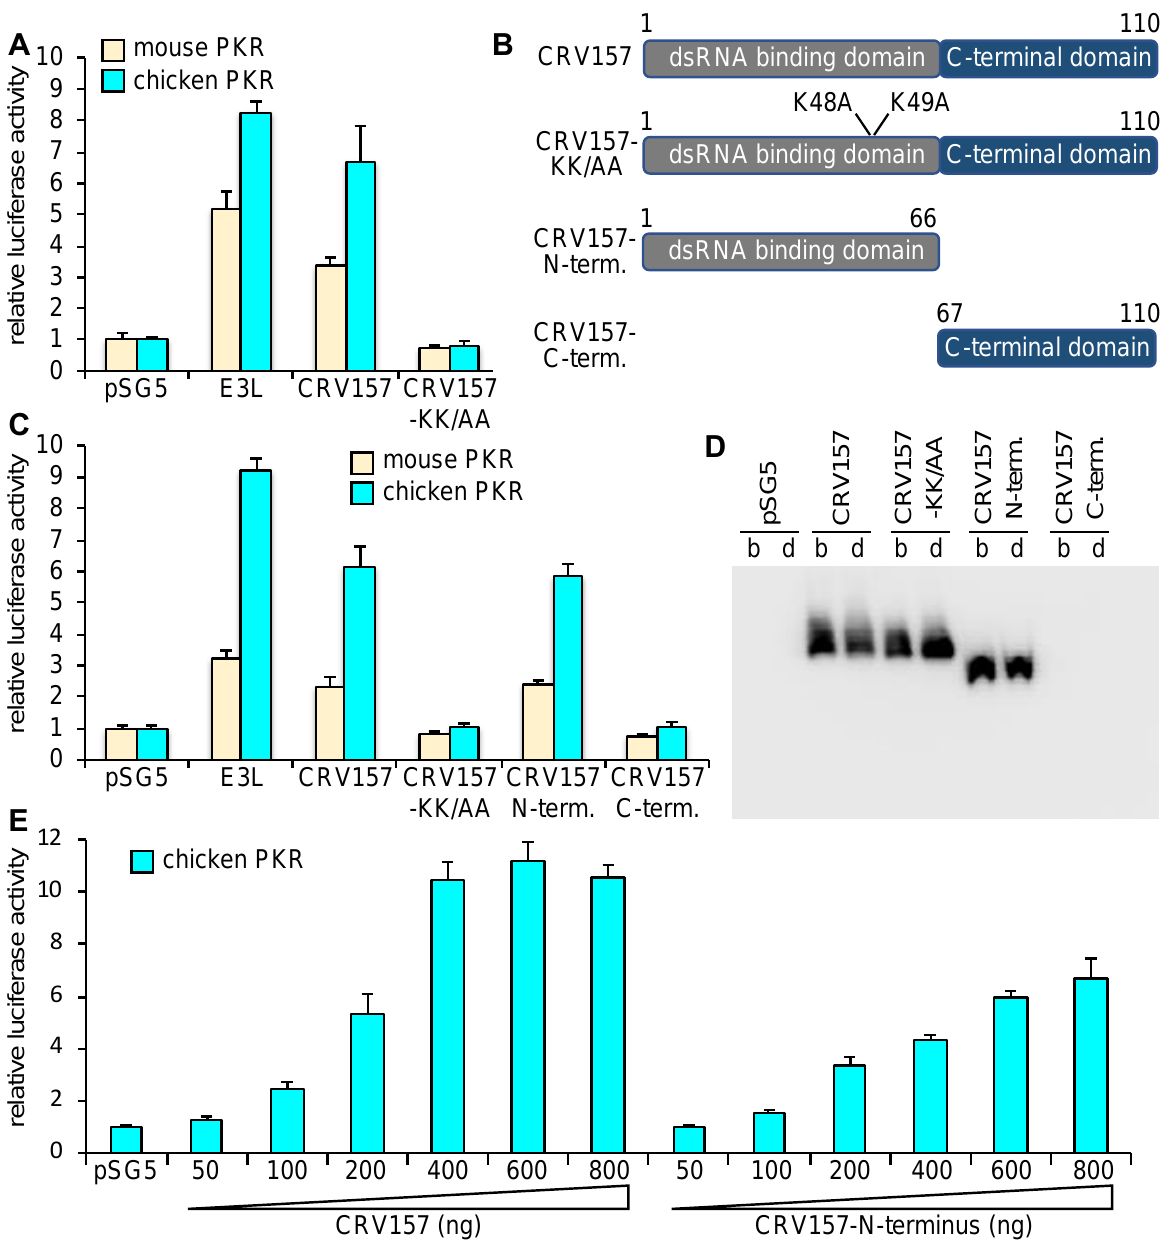
Figure 4. Inhibition of PKR by CRV157 and CRV157 mutants. ( A ) HeLa PKRkd cells were transfected with the luciferase expression vector pGL3 (0.05 µg), PKRs (0.2 µg) from mouse or chicken, and 0.8 µg of either plasmid vector, VACV E3L, CRV157, or CRV157-KK-AA. Luciferase activities were measured 48 h after transfection and normalized to PKR-only transfected cells. The standard deviations shown were calculated from three independent transfections. All results shown are representative of at least three independent experiments. ( B ) Overview of CRV157 constructs used. ( C ) In addition to the plasmids mentioned under (A), HeLa PKRkd cells were also transfected with CRV157-N-terminus (amino acids 1 – 66) or CRV157-C-terminus (amino acids 67 – 127) and assayed as described. ( D ) Western blot of total HeLa PKRkd cell lysates transfected with indicated FLAG-tagged constructs. Lysates were either run with b-mercaptoethanol (b) or Dithiothreitol (DTT, d) as reducing agents. ( E ) HeLa PKRkd cells were also co-transfected with increasing amounts of CRV157 or CRV156-N-terminus, along with chicken PKR 0.2 µg and pGL3 (0.05 µg). Luciferase activities were determined as described under A.